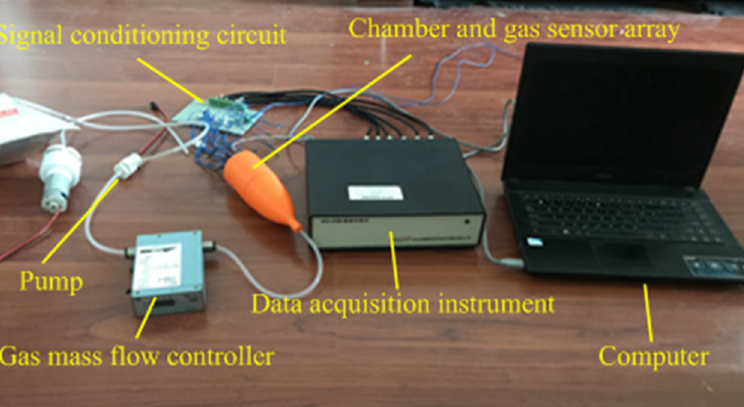
Figure 1. The developed electronic nose